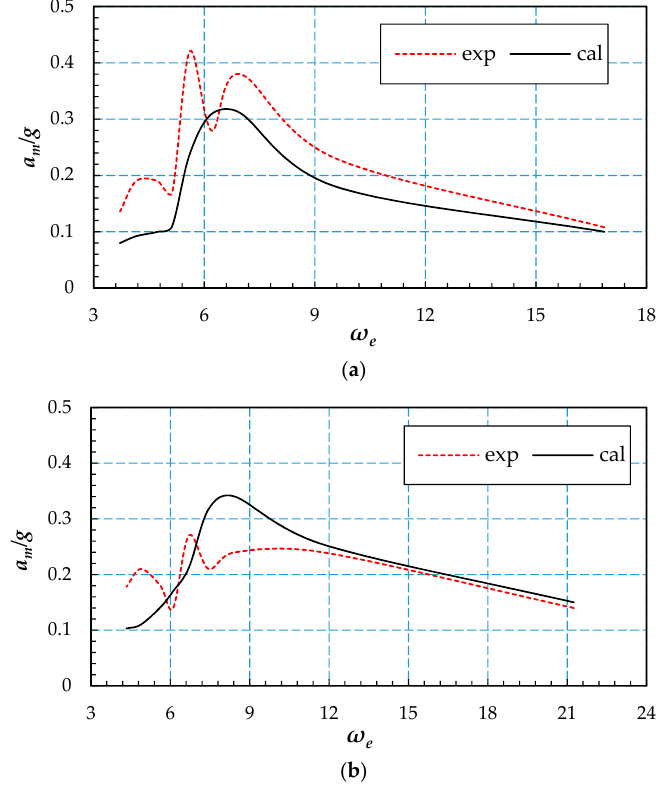
Figure 27. The contrast curves of amid-ships acceleration response of ( a ) F n = 0.71 and ( b ) F n = 0.99. Table 3 shows the amplitudes of different motion parameters at different speeds acquired in numerical simulation. Table 3. Calculated values of various amplitude responses.